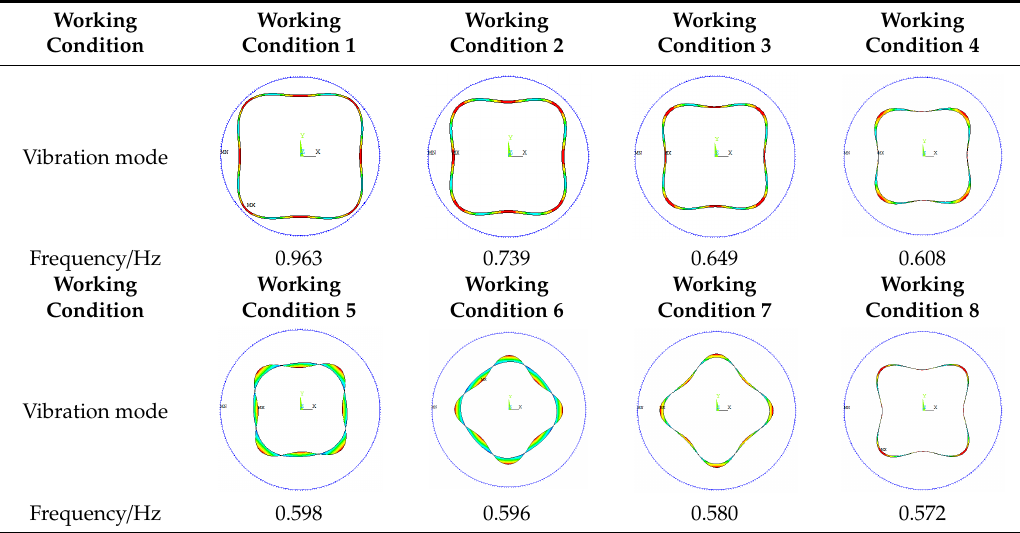
Table 3. Vibration modes at fundamental frequency under each working condition.